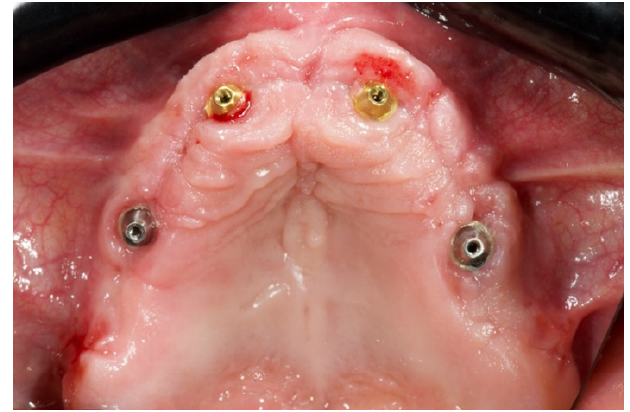
Figure 16. Implants with multi abutments in place: occlusal view.